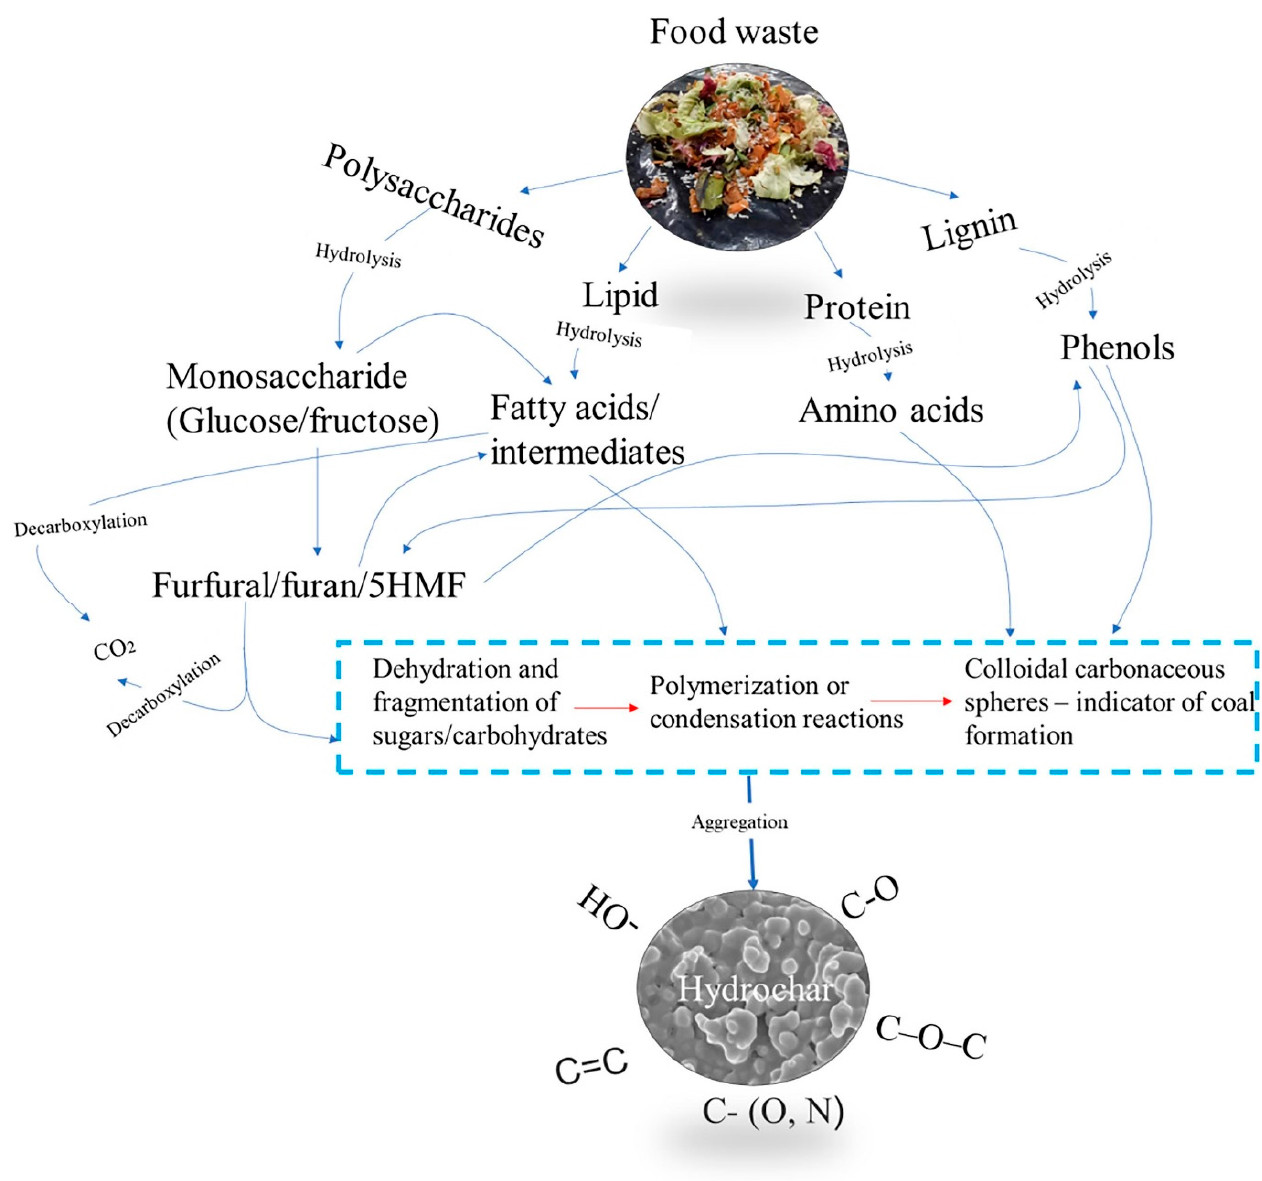
Figure 1. Reaction pathway for the HTC of food waste into hydrochar ([26].